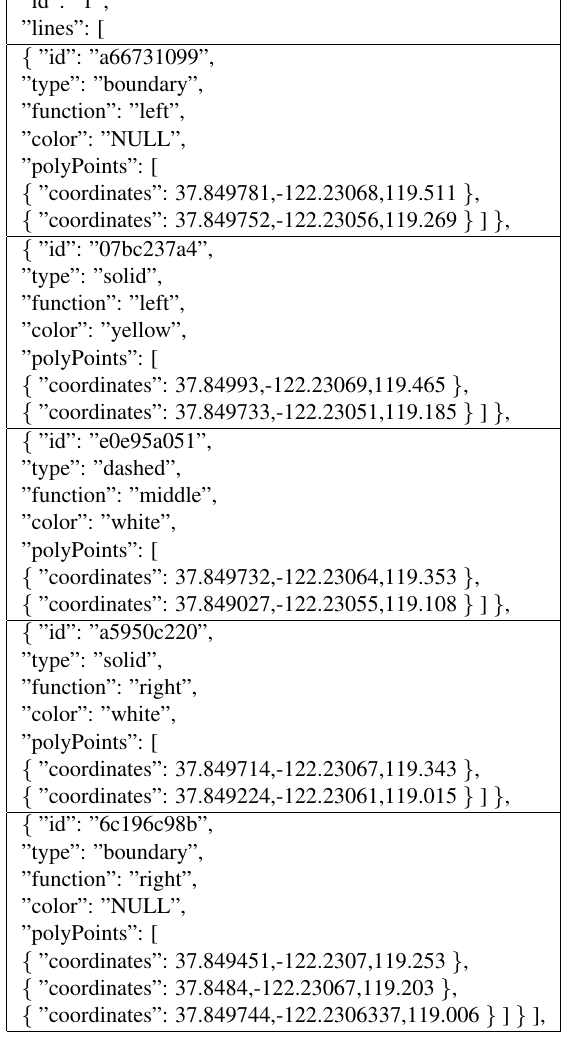
Table 1. A road segment in JSON format stored in the GIS database.